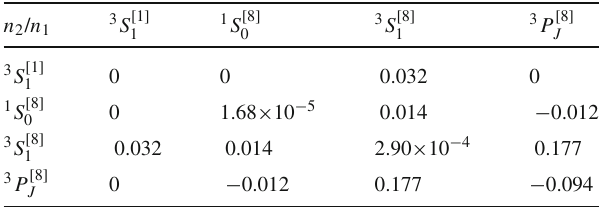
Table 3 The values of σ n in ( fb) up to order O (α 2 α 3 s ) . The con- 1 + n 2 vention introduced in Eq. (19) is adopted. The LDMEs are taken from Refs. [22,23]